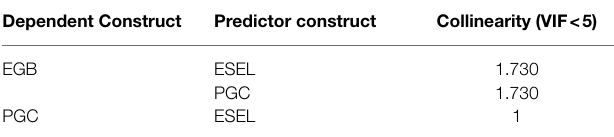
TABLE 7 | Collinearity